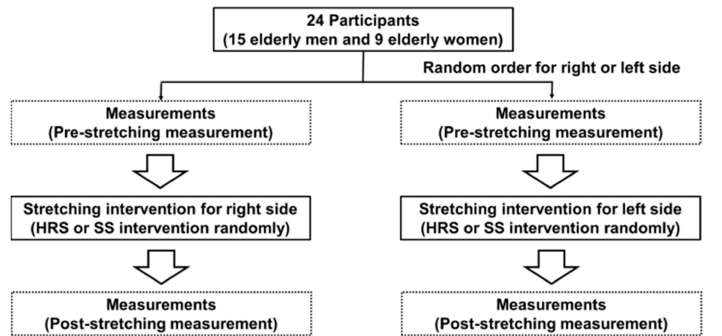
Figure 1. Experimental protocol of this study. HRS: hold–relax stretching, SS: static